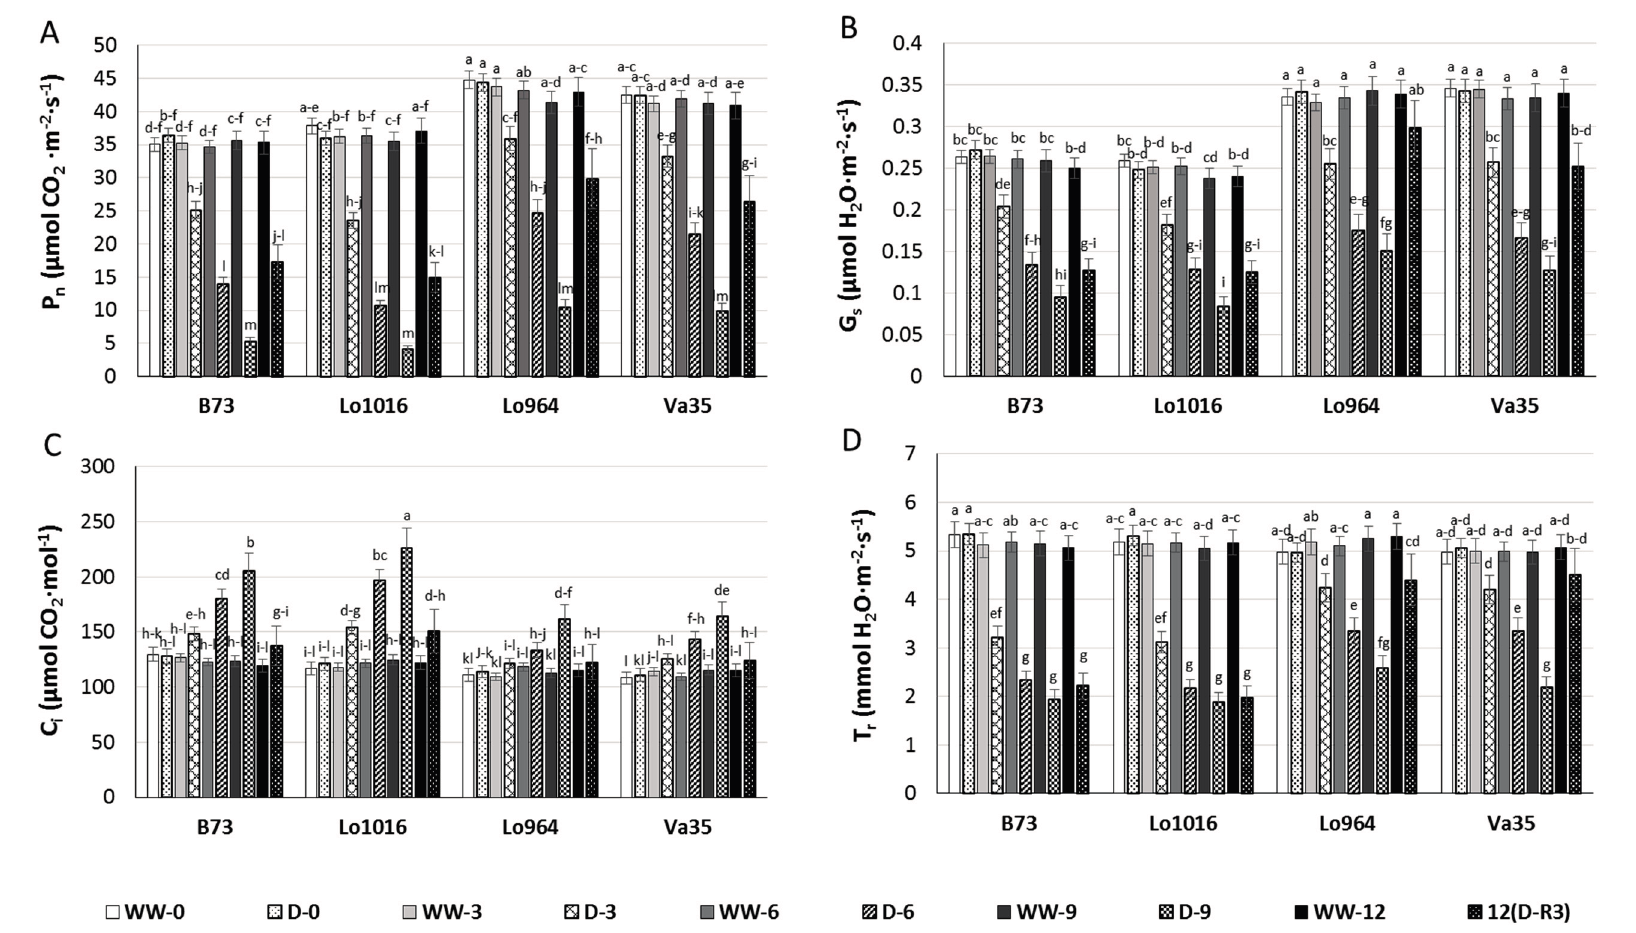
Figure 1. Photosynthetic parameters of seedling leaves from the sensitive genotypes, B73 and Lo1016, and the tolerant ones, Lo964 and Va35, under well-watered (WW) and drought stressed (D) conditions. Photosynthetic metrics were measured in sensitive and tolerant genotypes during drought stress and post-recovery including P n ( A ), G s ( B ), C i ( C ), and T r ( D ) measured from 9:00 to 11:00 in the morning for every collection time, at day zero (0), 3, 6, 9 or 12, on young leaves. Different letters indicate significant differences ( p < 0.05) based on Tukey’s test between control and treatments and between different treatment times. Data represent the mean ± SD of three or more